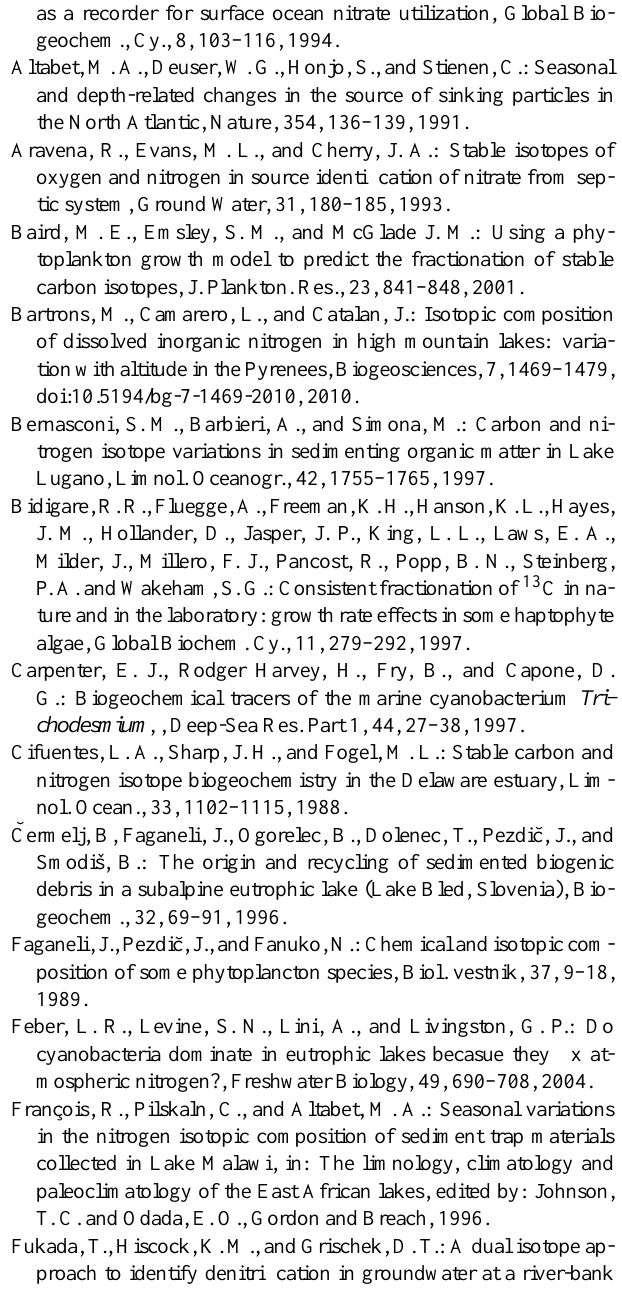
values and NO − concentrations, 3 3